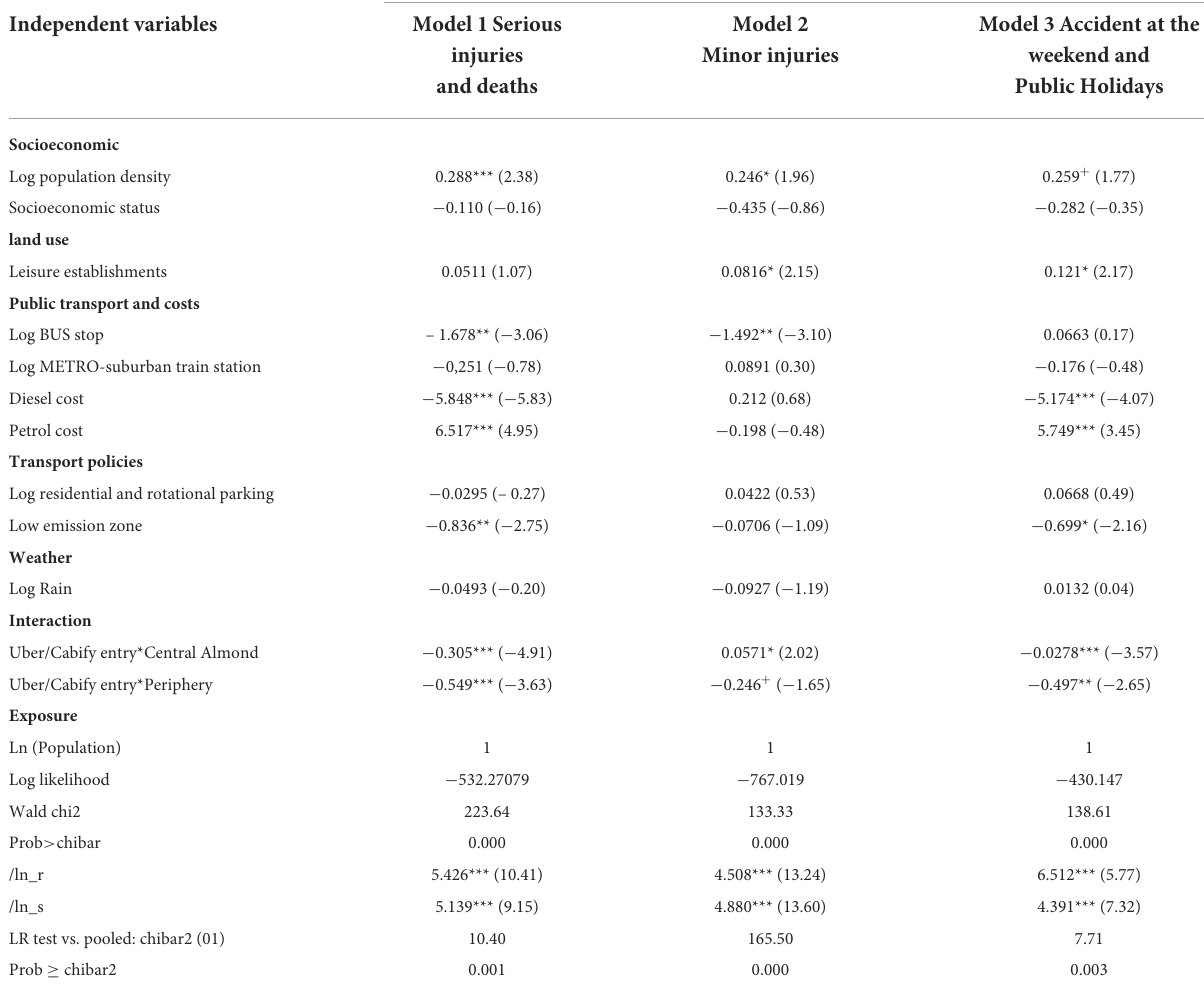
TABLE 5 Results of the estimated Model (z–statistics in